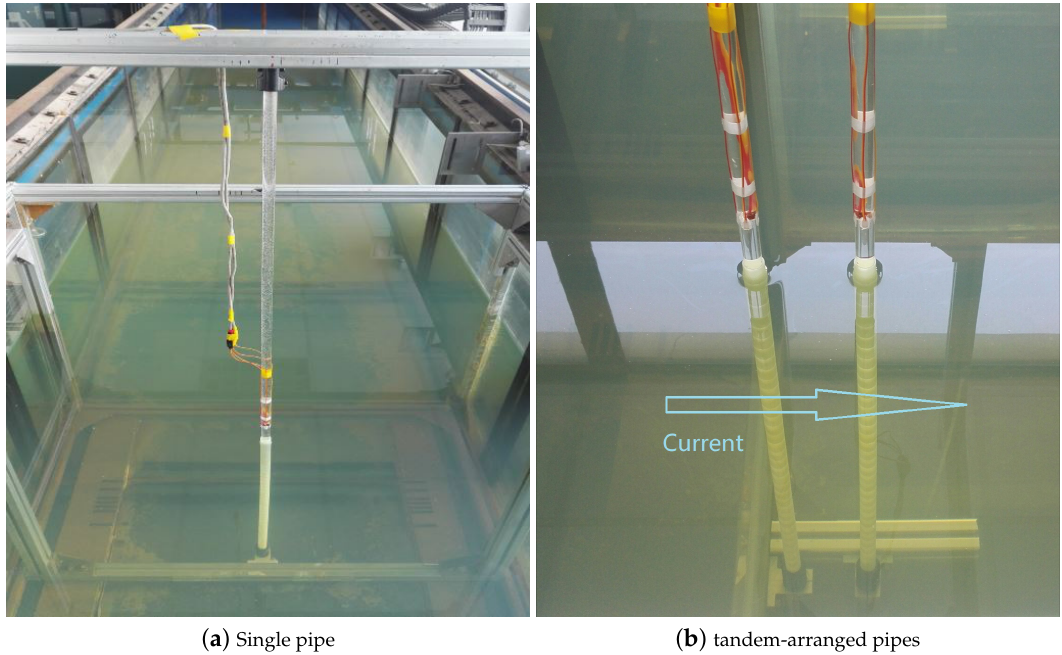
Figure 9. Experimental setup of ( a ) a single flexible pipe, and ( b ) a pair of tandem-arranged pipes of the same cross- sectional